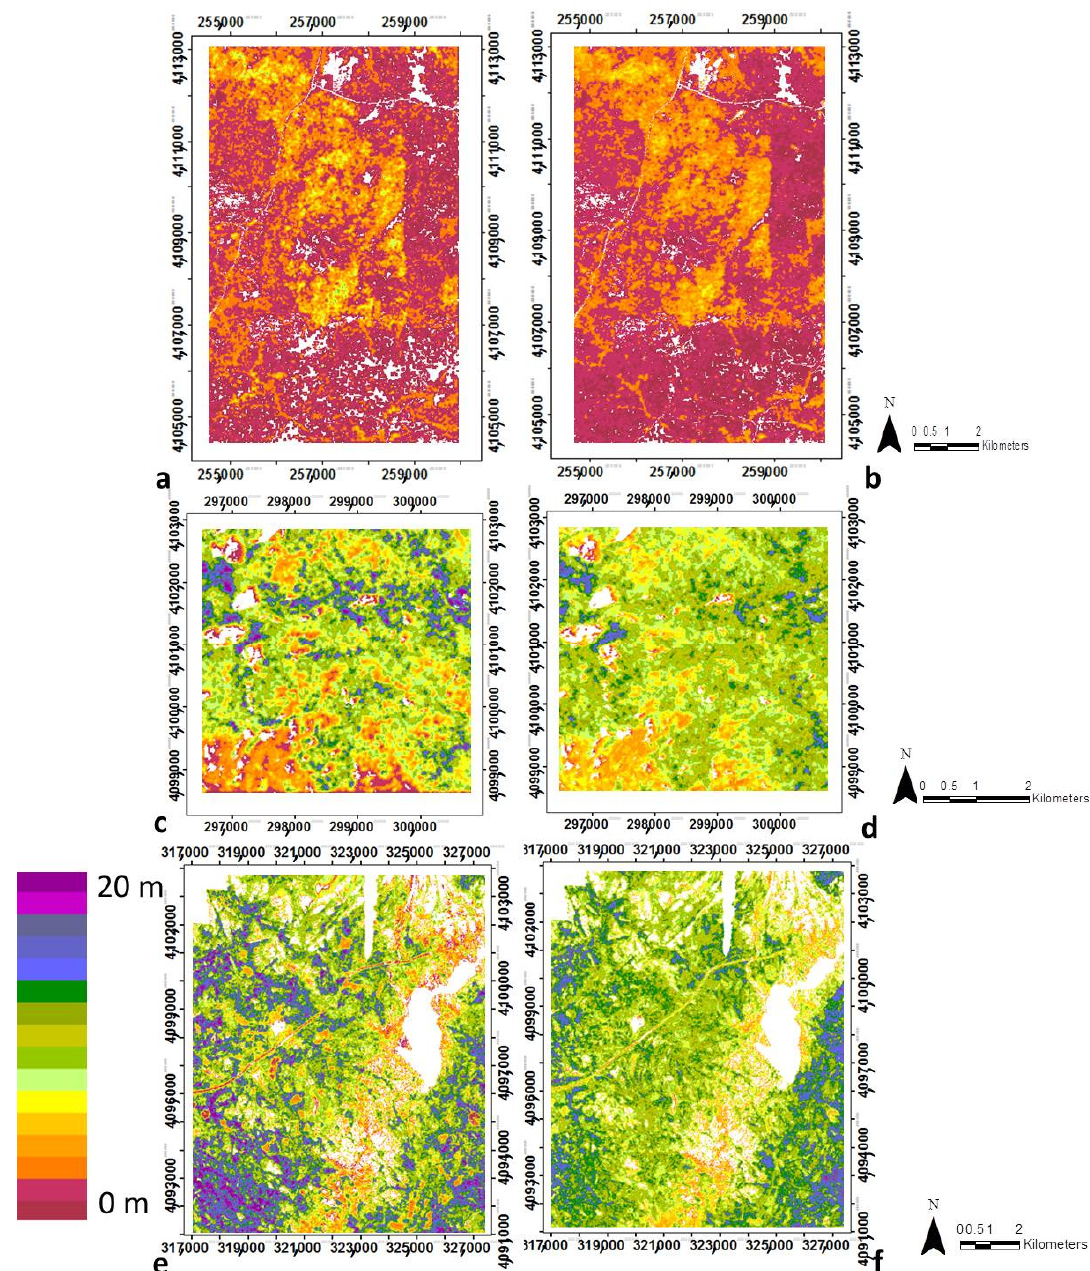
Figure 5. Spatial distribution of vegetation heterogeneity from LiDAR-derived data ( a , c , e ) and from Random Forests regression using optical metrics ( b , d , f ), for SJER ( a , b ), SOAP ( c , d ) and TEAK ( e , f ). White areas are non-vegetated, either water bodies, rock or bare ground, etc. Note regions are not to scale due to optimizing images and site size differences. See Supplementary Materials, Table S5 for the ranking of the input metrics.